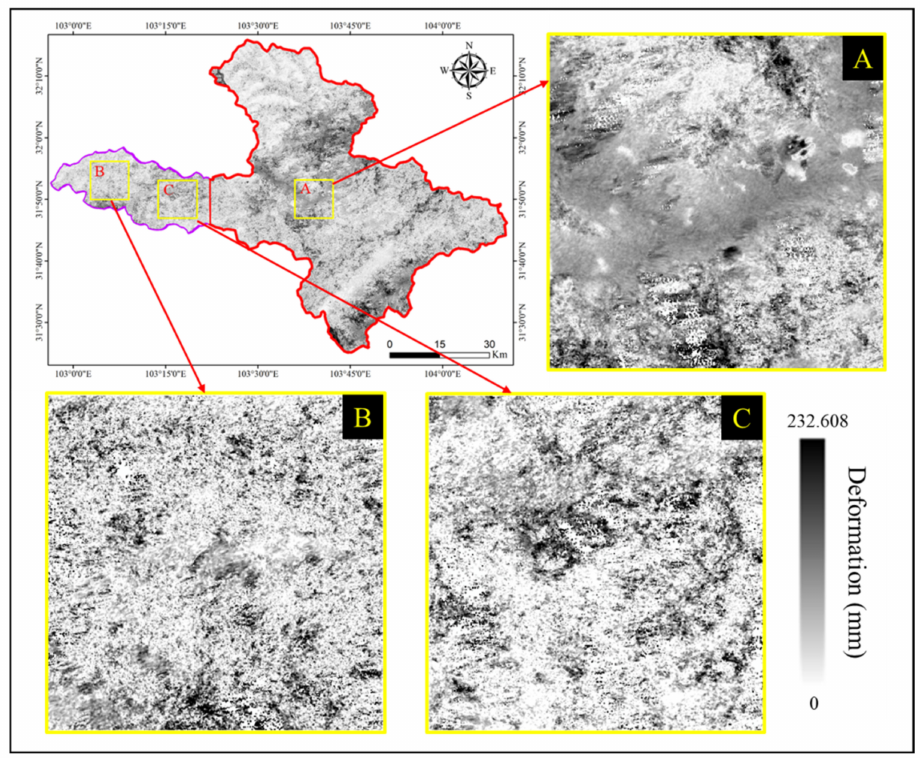
Figure 19. Locations of testing areas. ( A ) InSAR result of test area A, ( B ) InSAR result of test area B, and ( C ) InSAR result of test area C.